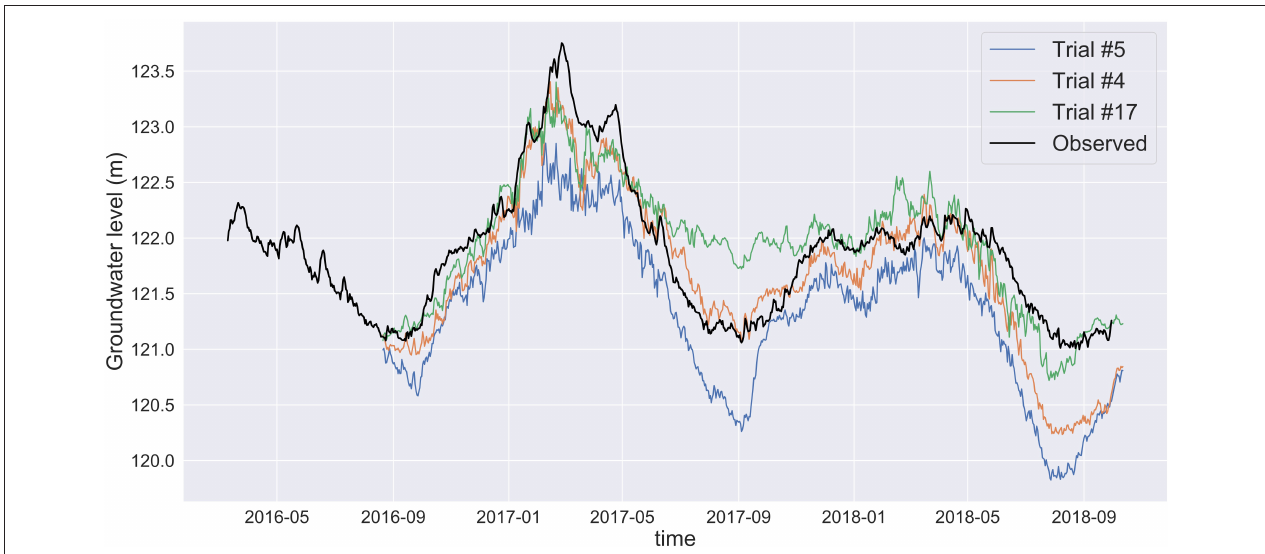
FIGURE 4 | MLP prediction for three trials with the same input features and hyperparameters at Shasta with different random seeds. The black time series shows the observed groundwater level and the other colors represent predictions from three ensemble members. The stochasticity in the training leads to different MLP models and corresponding different predictions. The prediction indicated by the Trial #5 (blue line) shows a large decrease of the groundwater level and has the highest prediction error. Trial #4 (orange line) is closest to the observed groundwater levels (truth) while Trial #17 (green line) shows a more optimistic future with less groundwater